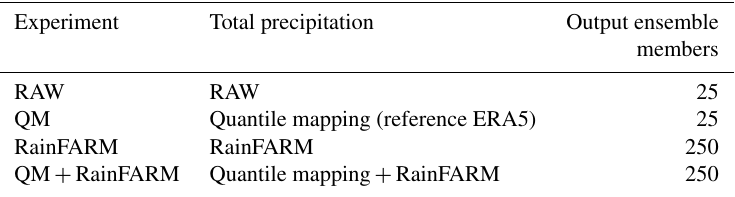
Table 3. Plan of experiments with the SNOWPACK model. The meteorological forcing is generated using ECMWFS5 and MFS6 seasonal forecast system